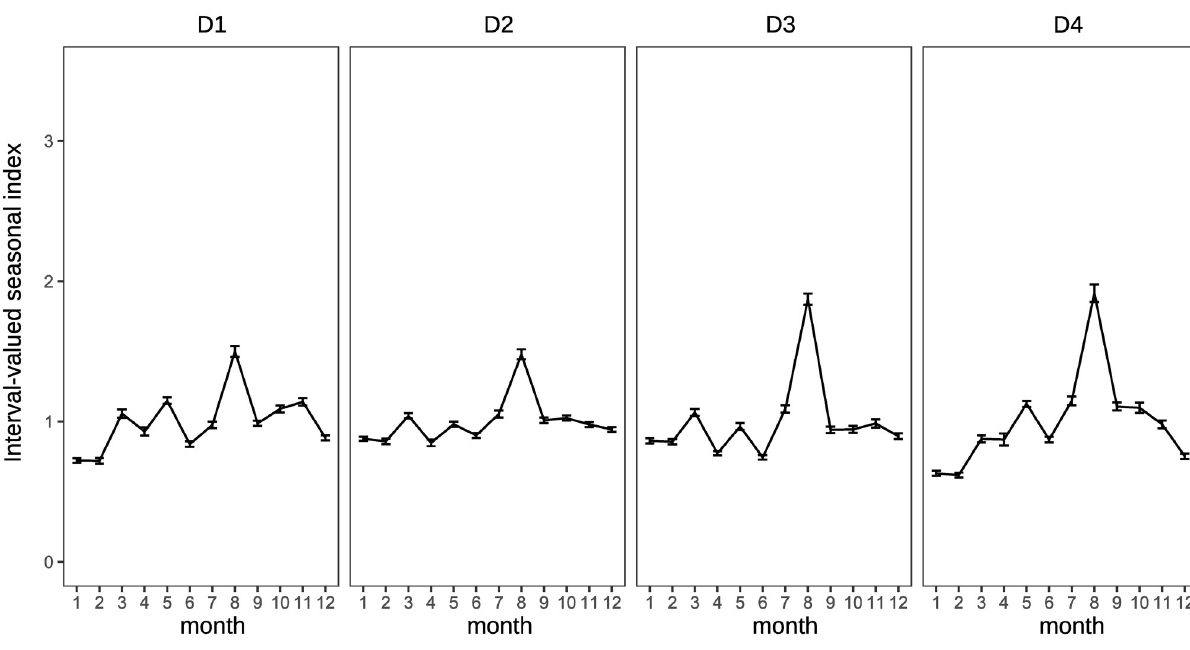
Fig 11. Interval-valued mean of each cluster for domestic guests.